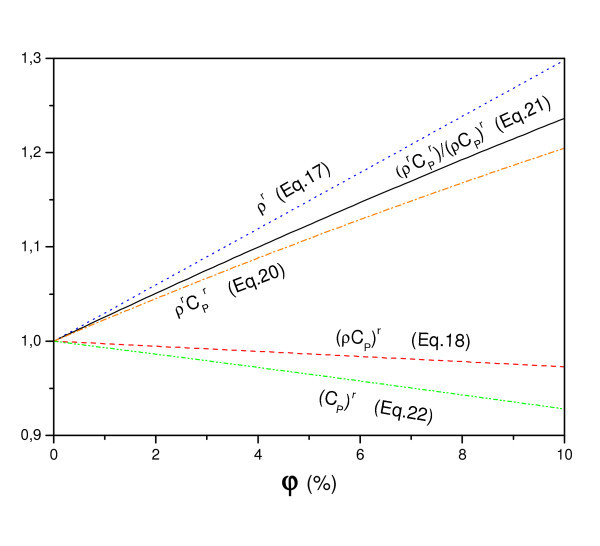
Specific heat capacity versus nanoparticle concentration (Al2O3).